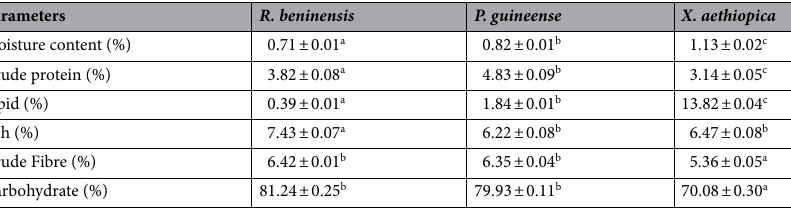
Table 3. Proximate composition of R. beninensis, P. guineense, and X. aethiopica spices. Values are expressed as mean ± standard error of mean ( X ± S.E.M.) in triplicate. Values with different letters along the same row are significantly different ( p < 0.05).